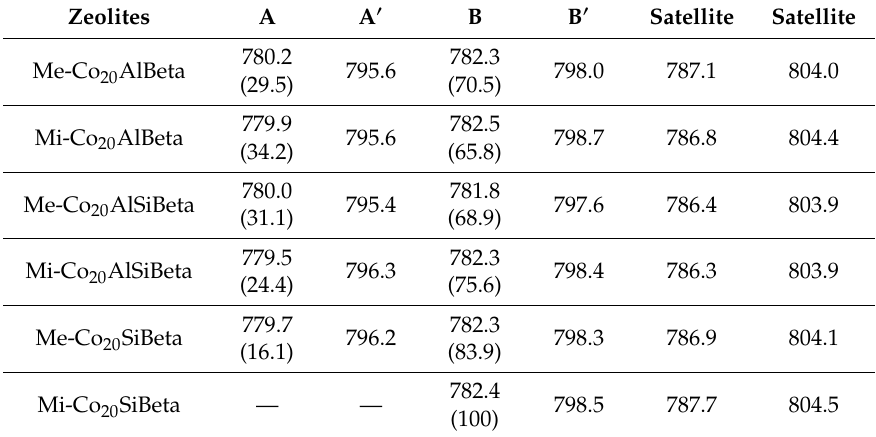
Table 1. The BE values (eV) and relative areas of components (%) of Co 2p core excitations obtained for microporous Mi-Co 20 Beta and mesoporous Me-Co 20 Beta